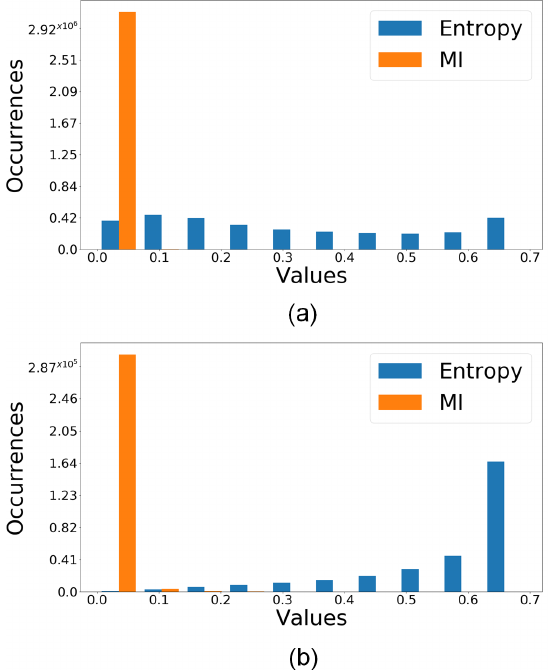
Figure 6. Distribution of correct and incorrect predictions for WiderNet 8 × , FCN-128 on the ESDB dataset. Please note that that the entropy has different distributions for the ( a ) correct vs. ( b ) incorrect predictions. This indicate that it is a good feature for quantifying the uncertainty (i.e., higher entropy means higher likelihood of having an incorrect prediction). Best in